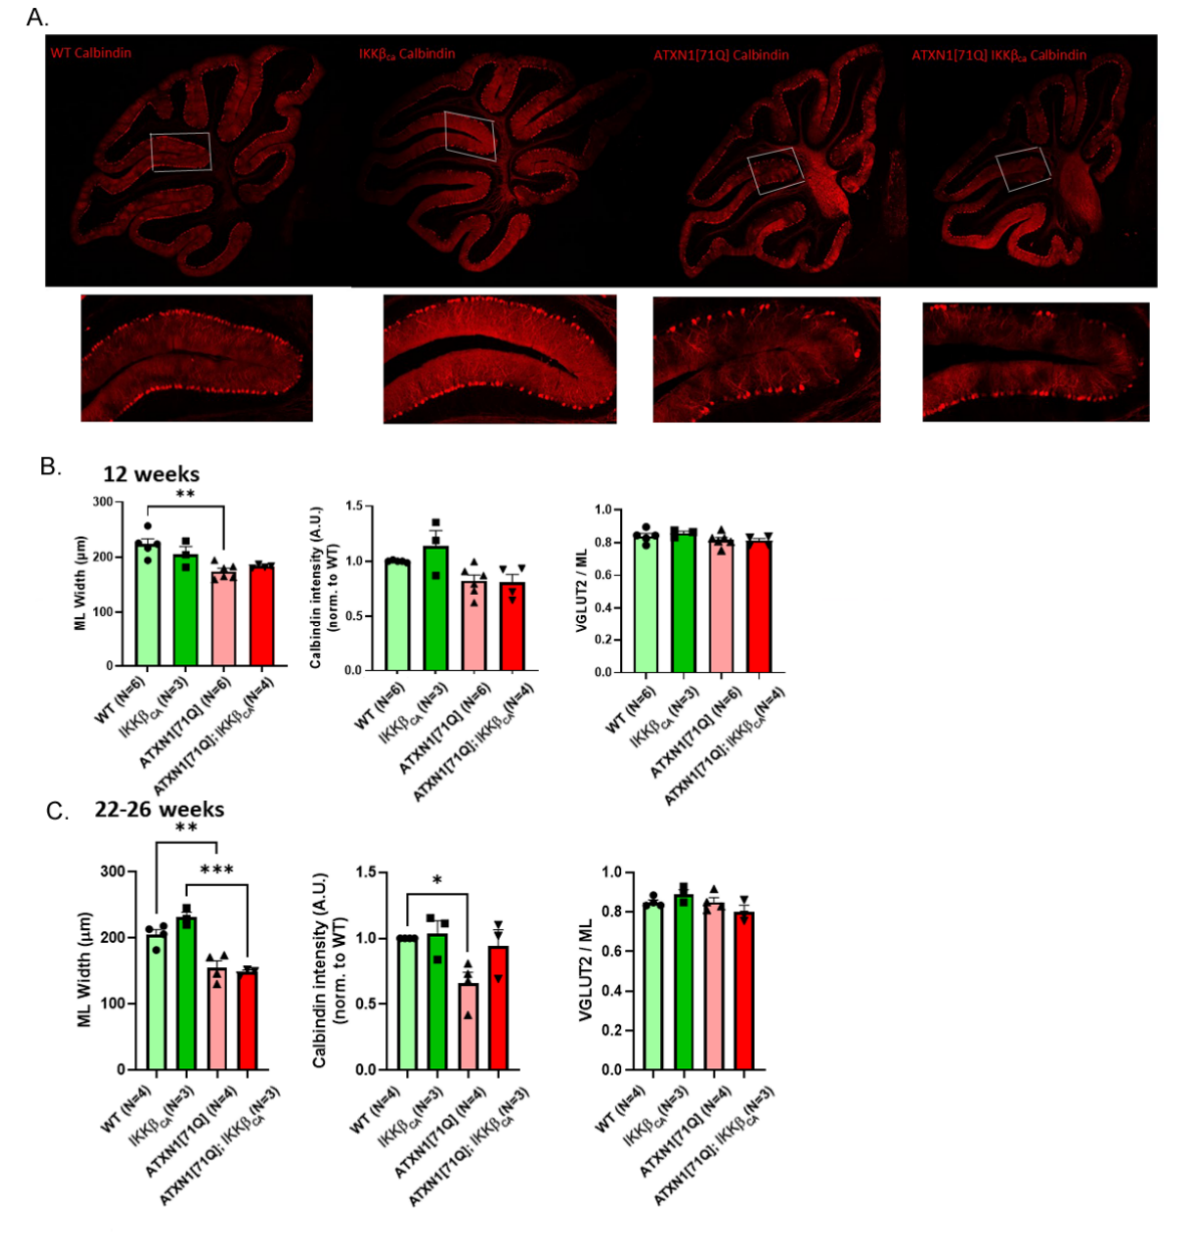
Figure 5. ATXN1[71Q] mice demonstrate Purkinje cell pathology despite lack of motor phenotype. Representative calbindin immunofluorescence staining of the whole cerebella of 12-week-old mice. Boxed regions of the molecular layer are shown below. ( A ) Cerebellar slices from 12- ( B ) and 22–26-week-old ( C ) mice were stained with antibody specific for Purkinje neuron-marker calbindin or with antibodies against calbindin and vesicular glutamate transporter 2 (VGLUT2) to label climbing fiber synapses on PNs. ImageJ was used to quantify molecular layer thickness, calbindin intensity in the Purkinje neurons, and length of climbing fiber synapses (VGLUT2 puncta) on Purkinje neuron dendrites (VGLUT2/calbindin). Data are presented as mean ± SEM with average values for each mouse represented by a dot. * p < 0.05, ** p < 0.005, *** p < 0.0005 using one-way ANOVA with Bonferroni’s multiple comparison test. Error bars = S.E.M.